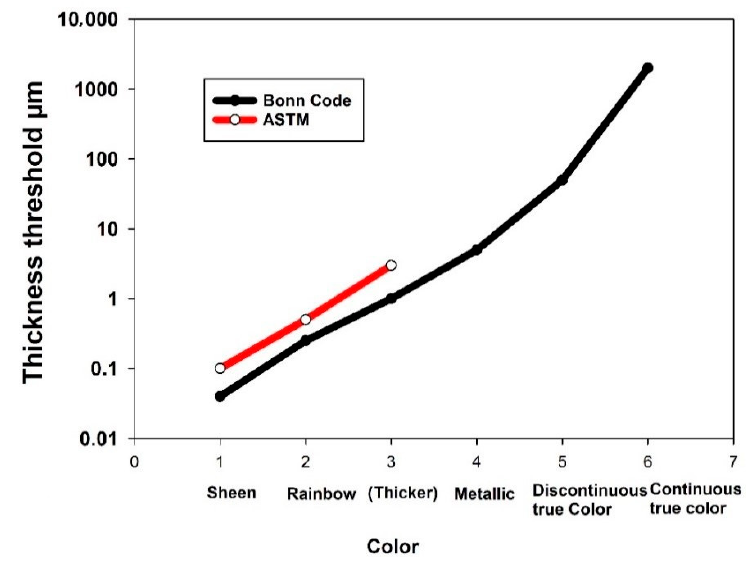
Figure 4. The comparison of the ASTM and Bonn Color Codes .